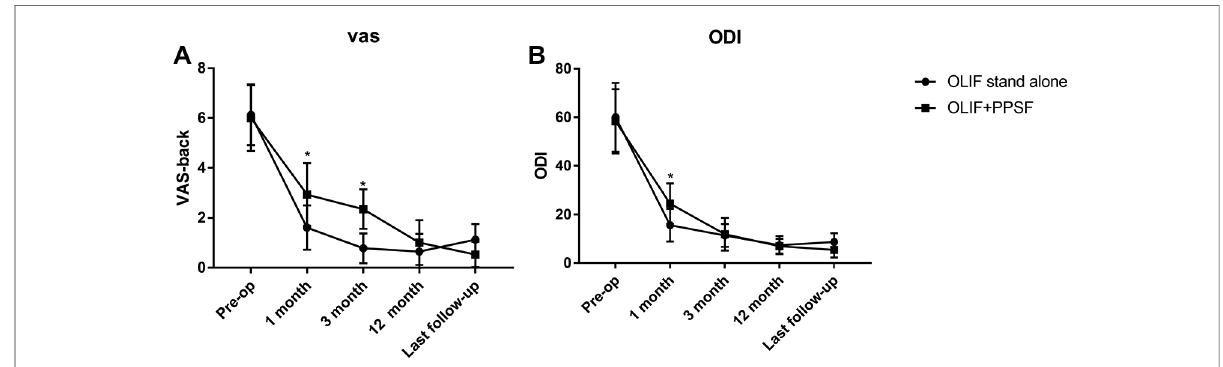
FIGURE 2 VAS ( A ) and ODI ( B ) score. Comparison between OLIF stand-alone and OLIF+PPSF from pre-operation to last follow-up. * P <0.05.